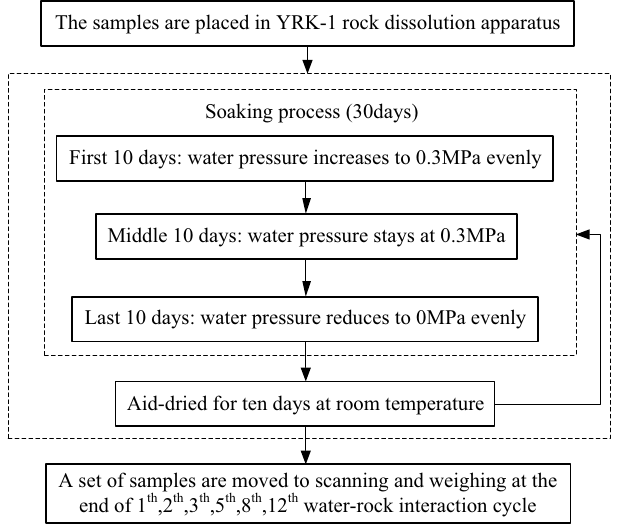
Figure 3. Flow chart of water–rock interaction test.